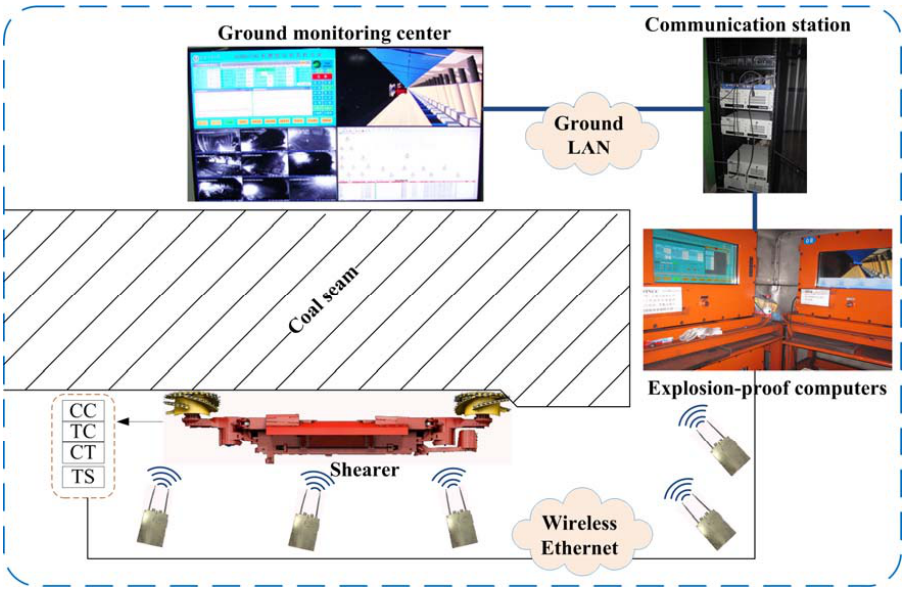
Figure 9. Field application example based on the proposed method.